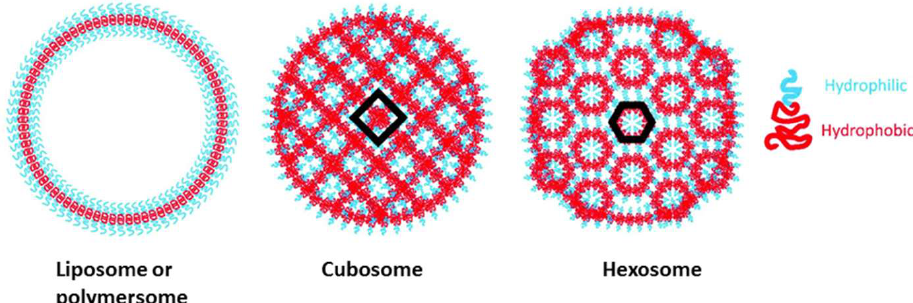
Figure 1. Arrangements of amphiphilic block copolymers in liposome (or polymersome), cubo- some, and hexosome type particles. Particle morphology depends on symmetry/asymmetry of hydrophilic/hydrophobic parts [156].